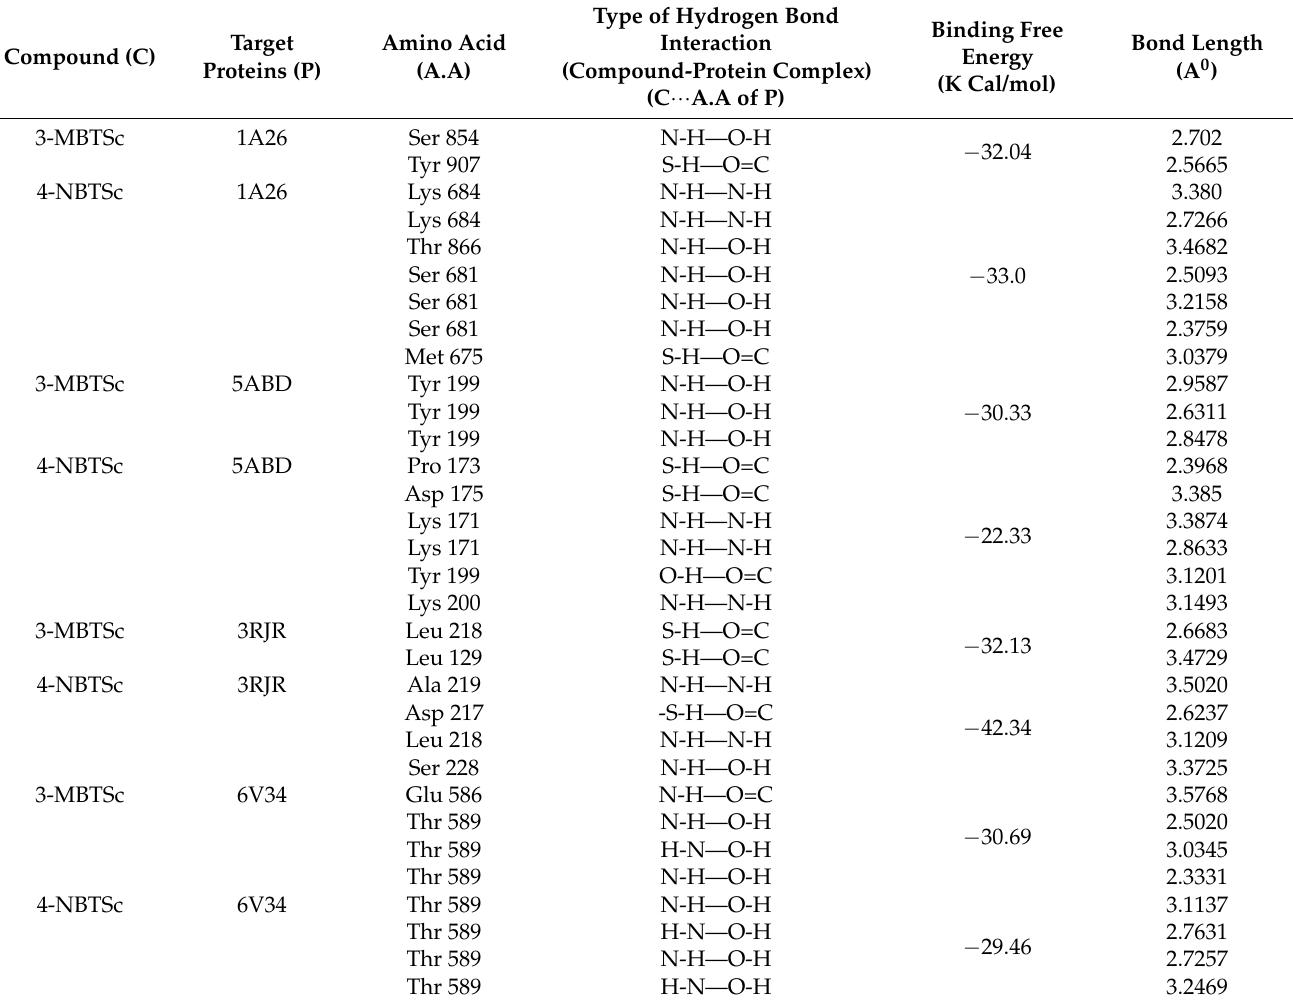
Table 1. Molecular docking results of 3-MBTSc and 4-NBTSc with targeted proteins expressed in breast and skin cancers.